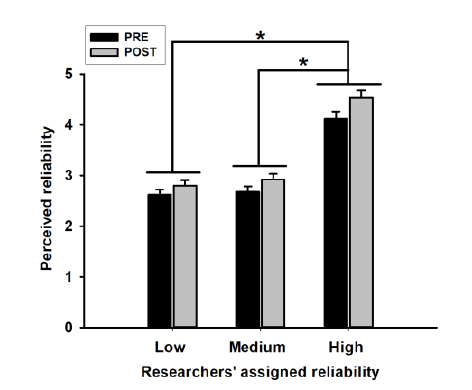
Figure 2. Perceived reliability mean score of sources of information (Mean ± S.E.M). The x- axis shows the three levels of reliability assigned by researchers to each source. Students perceived as with higher reliability sources classified as high reliability (* p